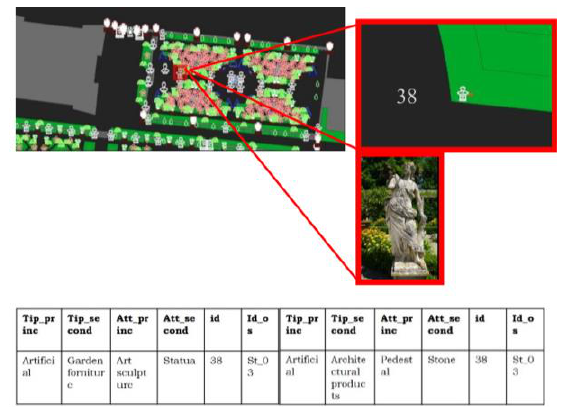
Figure 9. The mapping of the Gardens collected into the geodatabase